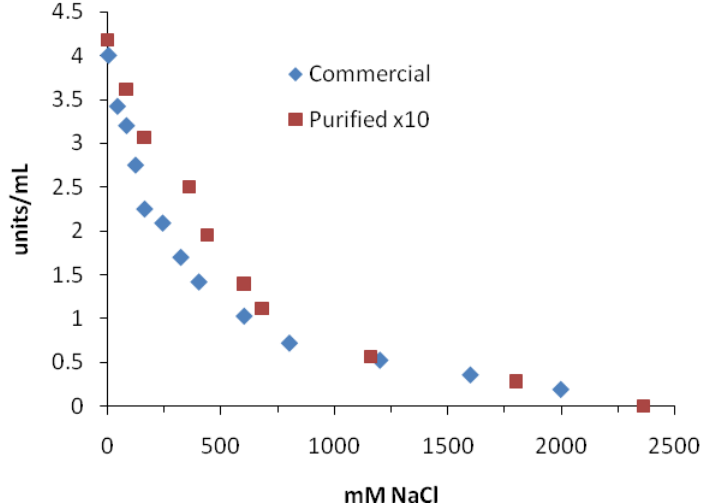
Figure 2. Inhibition of mushroom tyrosinase by NaCl. Assays were carried out as described in the Experimental section.